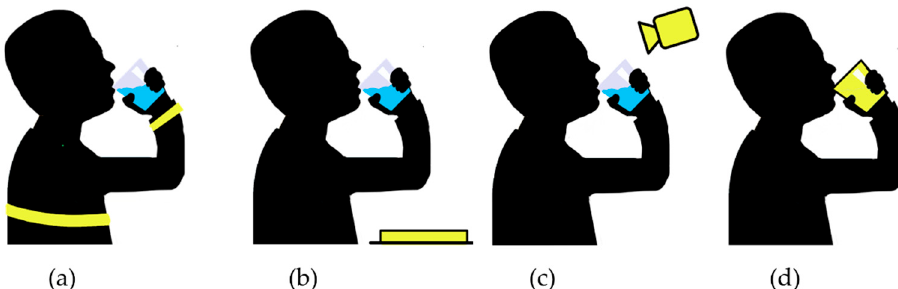
Figure 2. Images of the four reviewed categories including ( a ) wearables, ( b ) surface-based sensors, ( c ) vision and environmental based, and ( d ) smart containers .